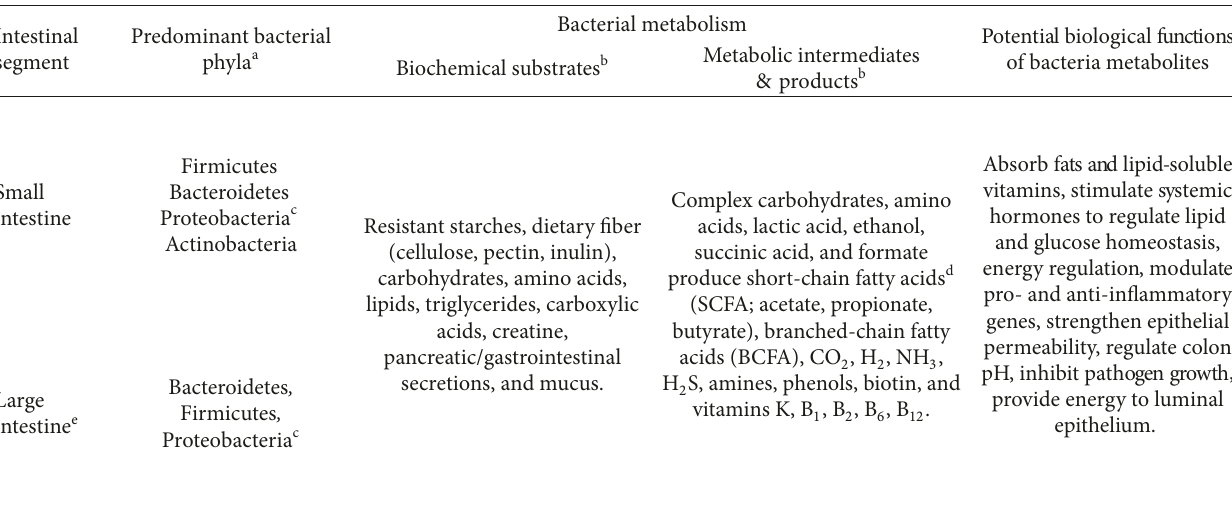
Table 2: Human intestinal microbiota: phyla, metabolism, and potential biological